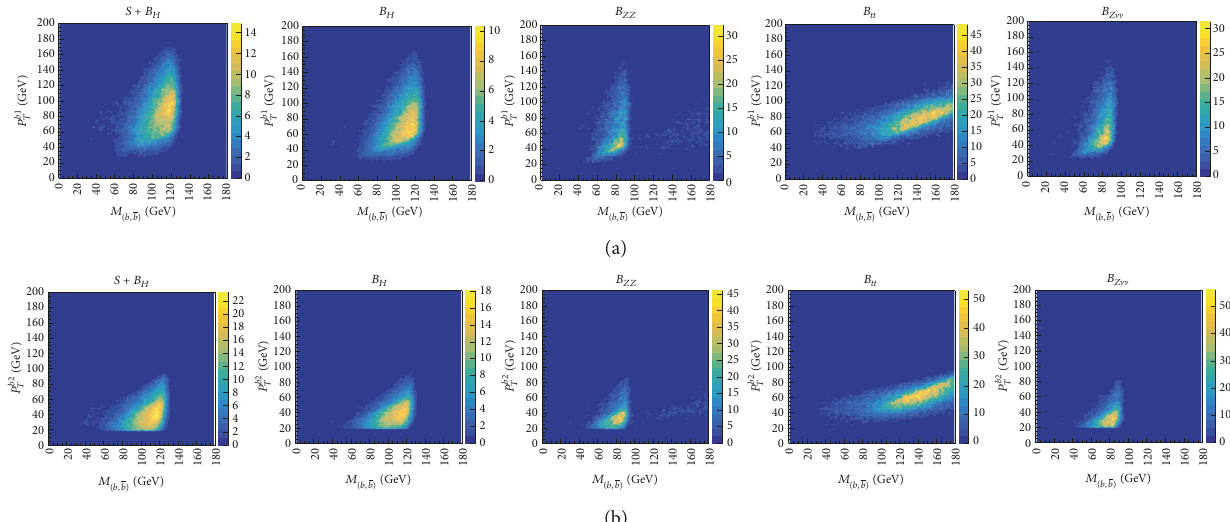
Figure 3: Normalized distributions of transverse momentum of tagged 𝑏 -jets; 𝑏1 (a) and 𝑏2 (b) versus reconstructed Higgs boson-mass from 𝑏1 and 𝑏2 ( 𝑀 𝑐 퐻푊 = 0.05 and relevant background processes. 푏,푏 ) for signal with